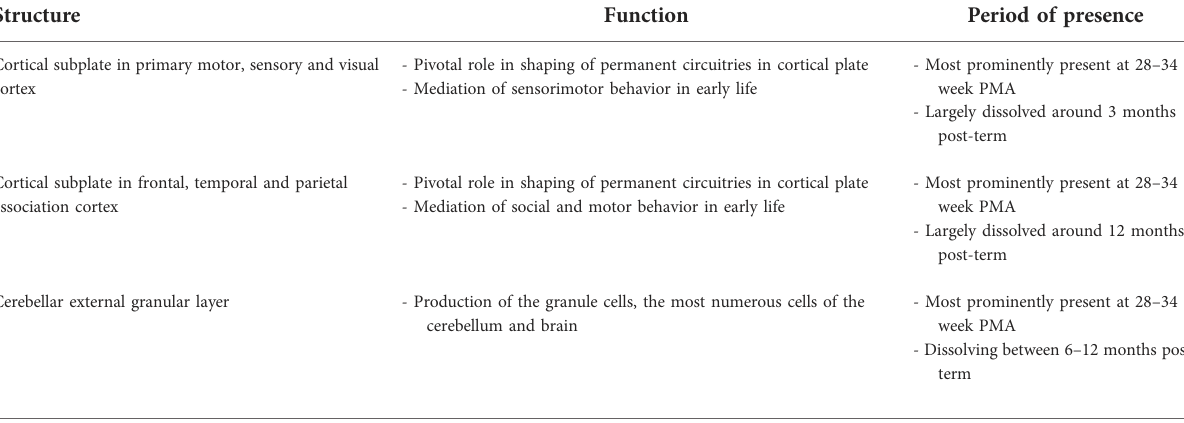
TABLE 1 Transient structures in the developing human